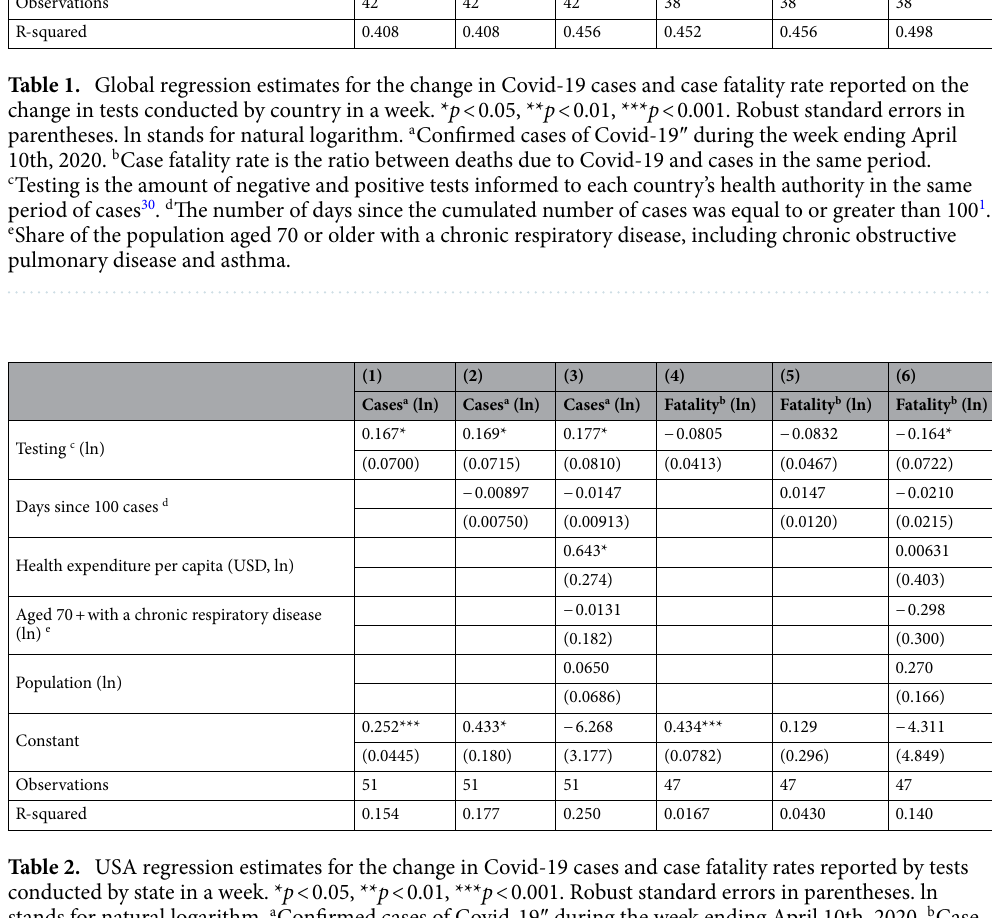
the same as in the previous period. Figure 2 shows four quadrants where countries would fall when they in- creased or decreased in either testing or PTR. If testing eligibility and the test remain unchanged, when both testing and PTR grow (quadrant I), the number of cases increases. Conversely, when testing and PTR decrease (quadrant III), the number of cases is declining. When countries or states move along the y-axis (change in PTR with a constant number of tests) or x-axis (change in tests with a constant PTR), a positive weekly change means more cases, and a negative weekly change means fewer cases. Nevertheless, for quadrants II and IV, the